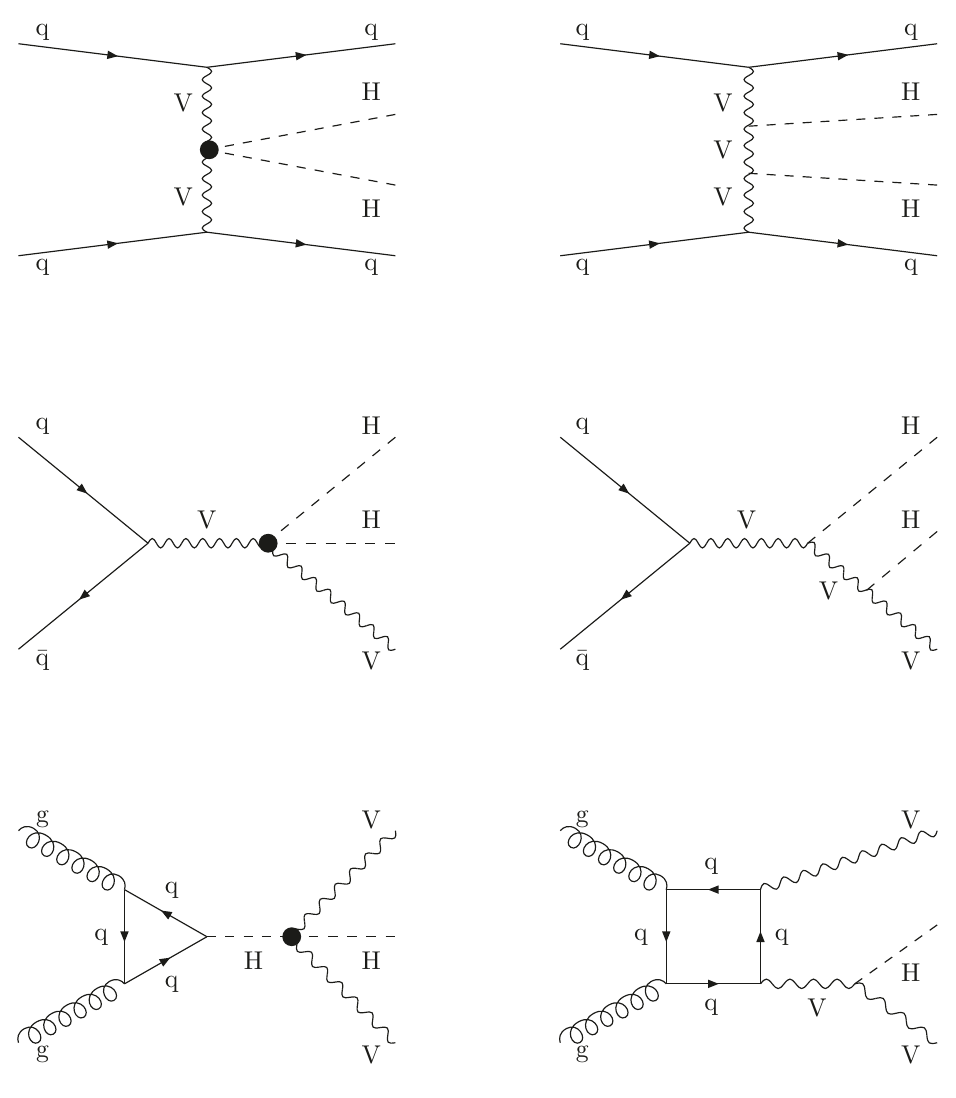
Figure 1 . Sample diagrams relevant to the VBS channel (top row), the VHH channel, (middle row), and the loop-induced ggVVH channel (bottom row). Contributions from higher dimension operators are collected on the left, while SM interactions are on the